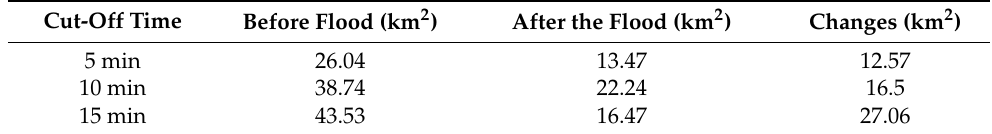
Table 4. Comparison of Service area variation.